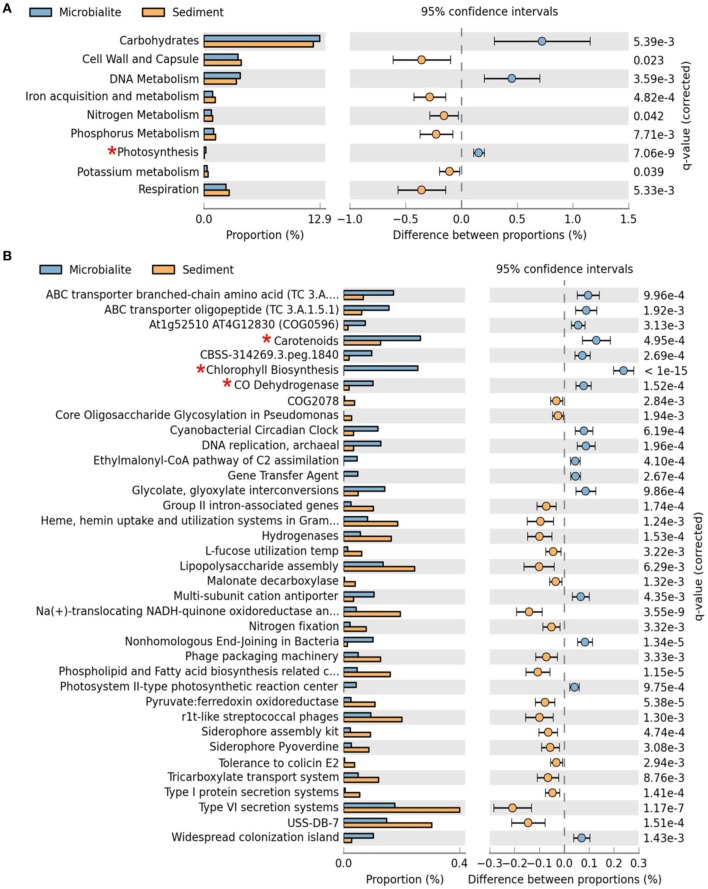
Extended error plots for functional gene annotations for Clinton Creek metagenomes in STAMP using SEED subsystems. (A) SEED subsystem level I (highest level classification in SEED). (B) SEED subsystem level III (3rd lowest classification in SEED out of four levels). Extended error plots used a one sided G-test (w/Yates' + Fisher's) with asymptomatic confidence intervals (0.95) using Benjamini-Hochberg FDR procedure. *Red asterisks are significant photosynthetic pathways.